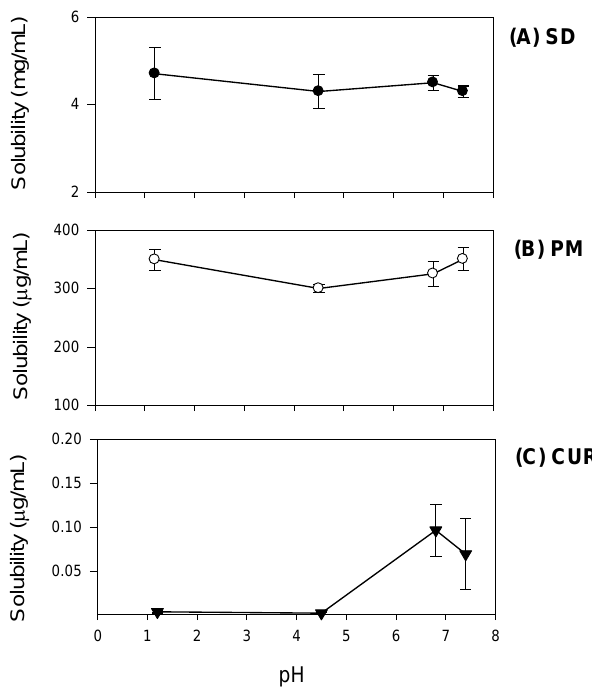
Figure 4. pH-dependent solubility of curcumin was determined for curcumin (CUR, ▼; A ), physical mixture of curcumin:TPGS:mannitol = 1:10:15 ( w / w / w ) (PM, ○; B ), and curcumin-loaded solid dispersion (SD, ; C ) in the pH range of 1.2–7.4. Each data point represents the mean ± S.D. of three independent experiments.